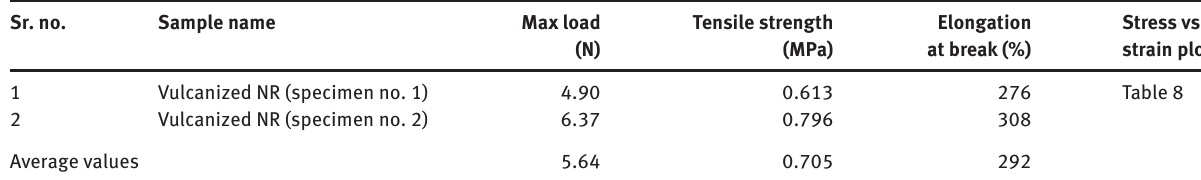
Table 6: Mechanical properties of vulcanized NR after water resistance at ambient temperature for 8 h. Sr. no.